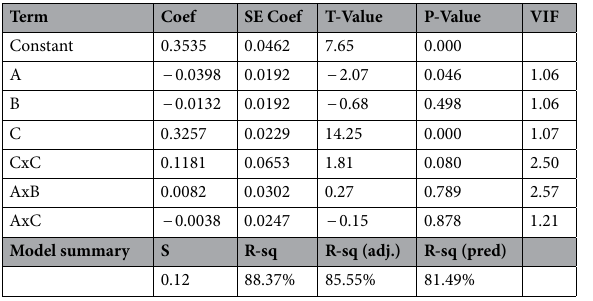
Table 5. Factorial fit: SE versus A, B, and C. ‘p-value’: a 5% significance level; Coef. coefficient; adj. adjusted, pred.